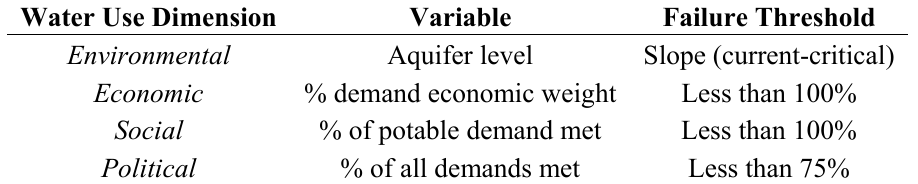
Table 2. Sustainability variables and failure thresholds for water use